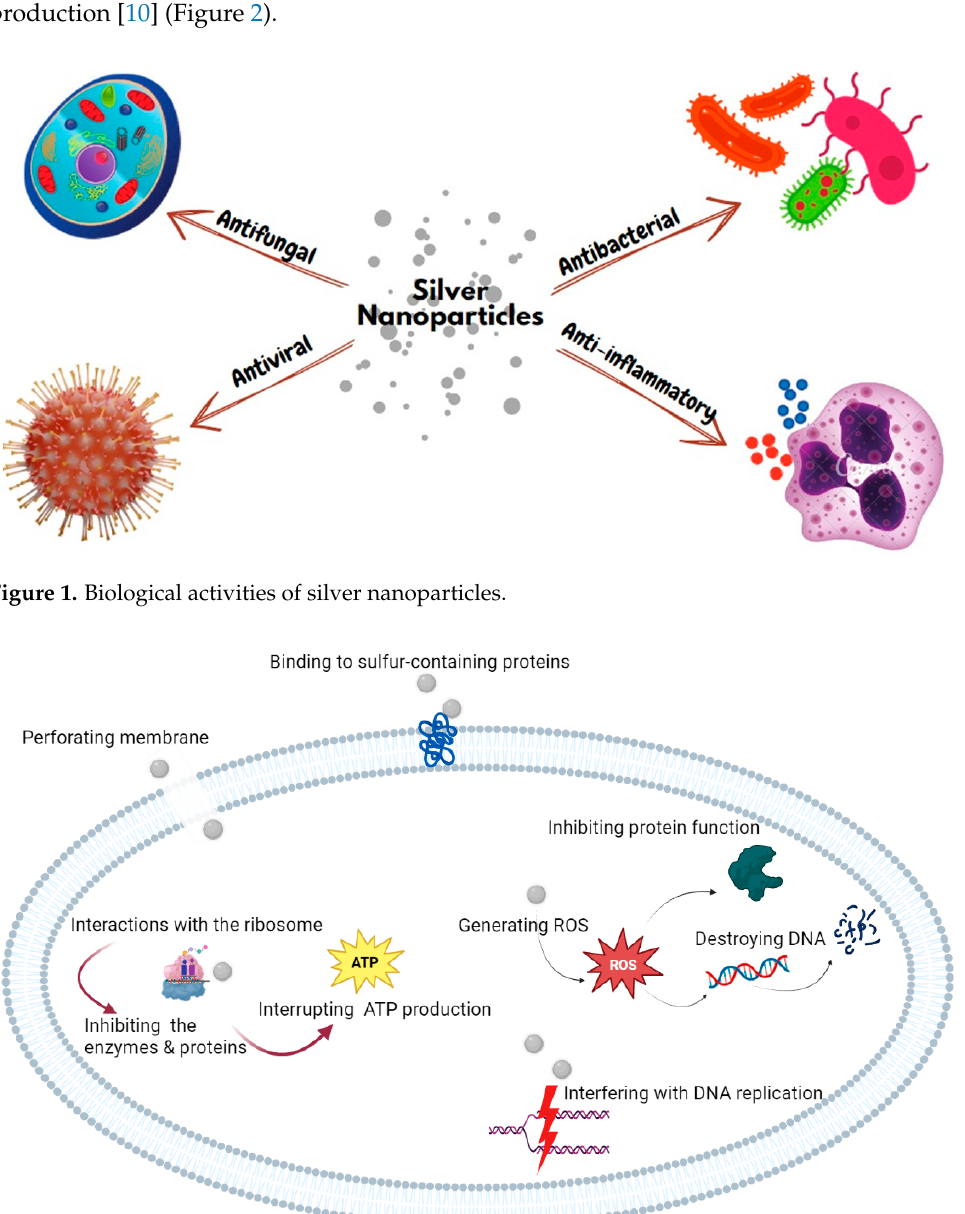
Figure 2. Mechanism of action of silver nanoparticles on bacteria.